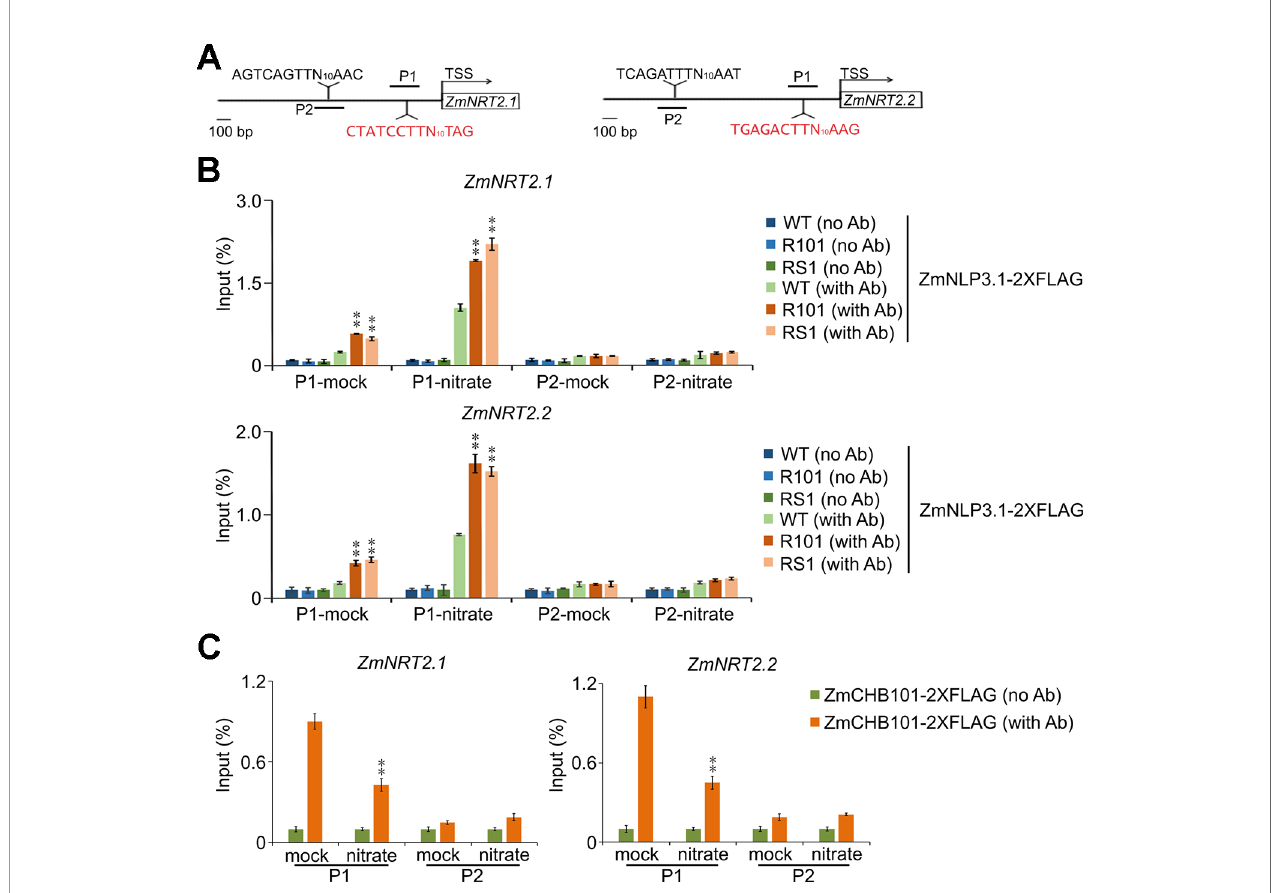
FIGURE 6 | Knockdown of ZmCHB101 enhances the binding of ZmNLP3.1 to the promoter regions of ZmNRT2.1 and ZmNRT2.2 . (A) Schematic representation of ZmNRT2.1 and ZmNRT2.2 promoters showing the ZmNLP3.1-binding site (P1) and non-ZmNLP3.1-binding site (P2). The NREs located at the -1 nucleosome position are indicted in red. (B) The binding of ZmNLP3.1 to NREs in ZmNRT2.1 and ZmNRT2.2 promoters was enhanced in ZmCHB101-RNAi lines. Nitrate-free WT and ZmCHB101-RNAi protoplasts were transformed with pro35S:ZmNLP3.1-2×FLAG and then treated with 0.5 mM nitrate for 0 or 2 h. ChIP-qPCR was performed using anti-FLAG antibody. The binding of ZmNLP3.1 to NREs in ZmNRT2.1 and ZmNRT2.2 promoters was enhanced in ZmCHB101-RNAi protoplasts compared with WT protoplasts. Asterisks indicate signi fi cant differences between WT and R101 or RS1 (**, p < 0.01; Student's t -test). (C) Nitrate treatment dissociates ZmCHB101 from the -1 nucleosome position in ZmNRT2.1 and ZmNRT2.2 promoters. WT protoplasts were transformed with pro35S:ZmCHB101- 2×FLAG and then treated with 0.5 mM nitrate for 0 or 2 h. ChIP-qPCR was performed using anti-FLAG antibody. Mock, nitrate treatment for 0 h; nitrate, nitrate treatment for 2 h. Asterisks indicate signi fi cant differences between mock and nitrate conditions (**, p < 0.01; Student's t